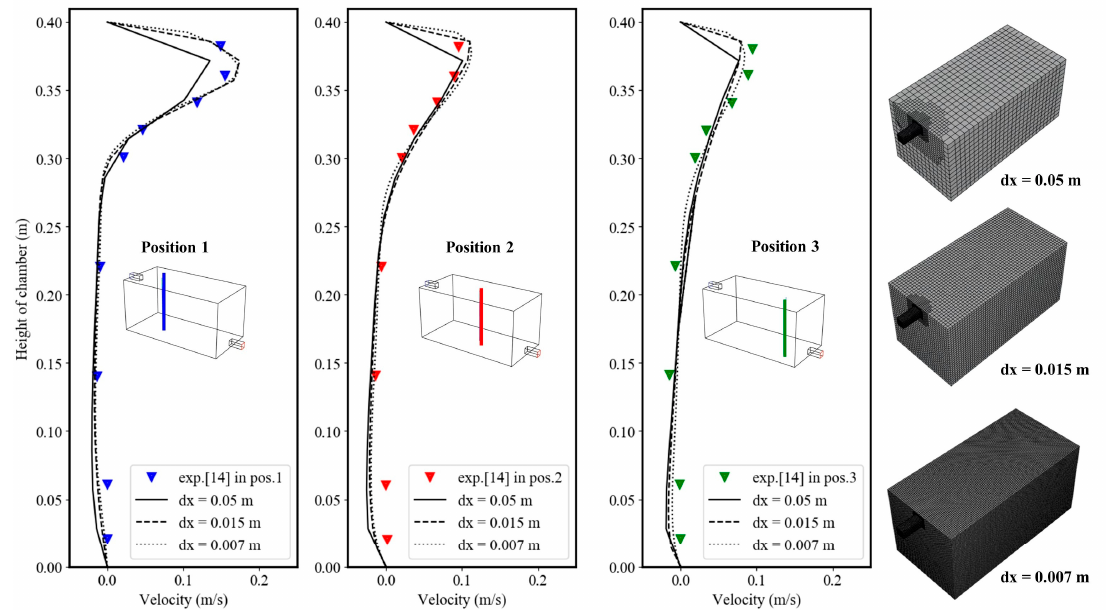
Figure 5. Mesh independence results. The experiment data were cited in [14]. The max length of the grid is decreased to 0.05, 0.015 and 0.007 m. The measurement positions are 0.2, 0.4 and 0.5 m from the wall.